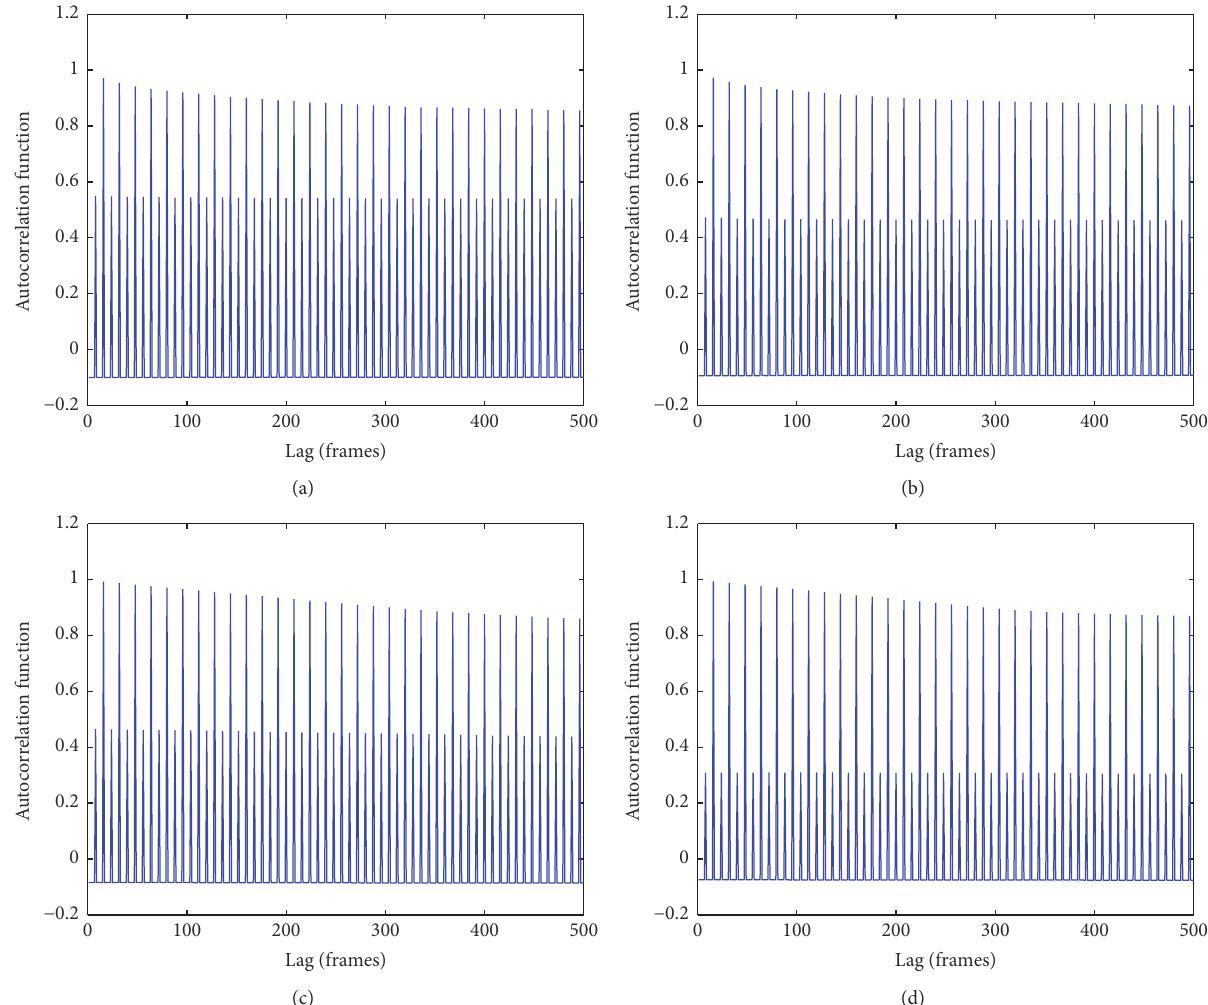
Figure 2: (a) and (b) ACF of NBC NEWS base layer and enhancement layer and (c) and (d) ACF of Sony Demo base layer and enhancement